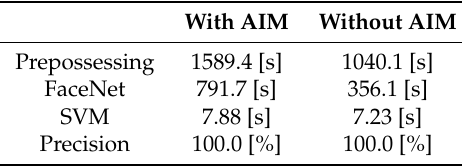
Table 4. Computational time for re-training face